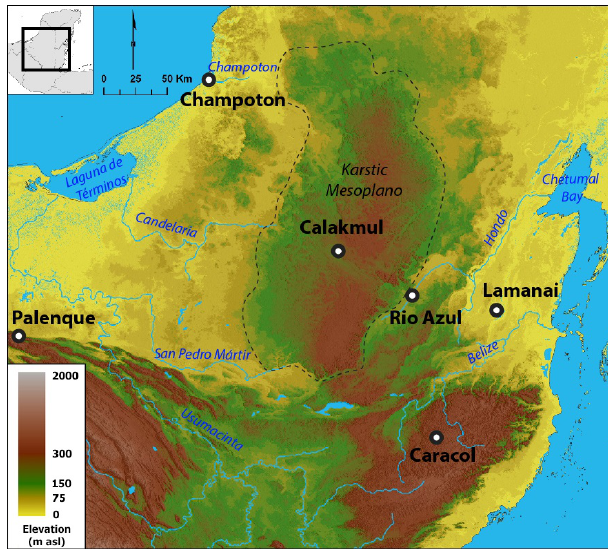
Fig. 5 . Central Maya lowlands, geology and topography. Cities used in this study and Karstic Mesoplano/Coastal Plain topography (B.